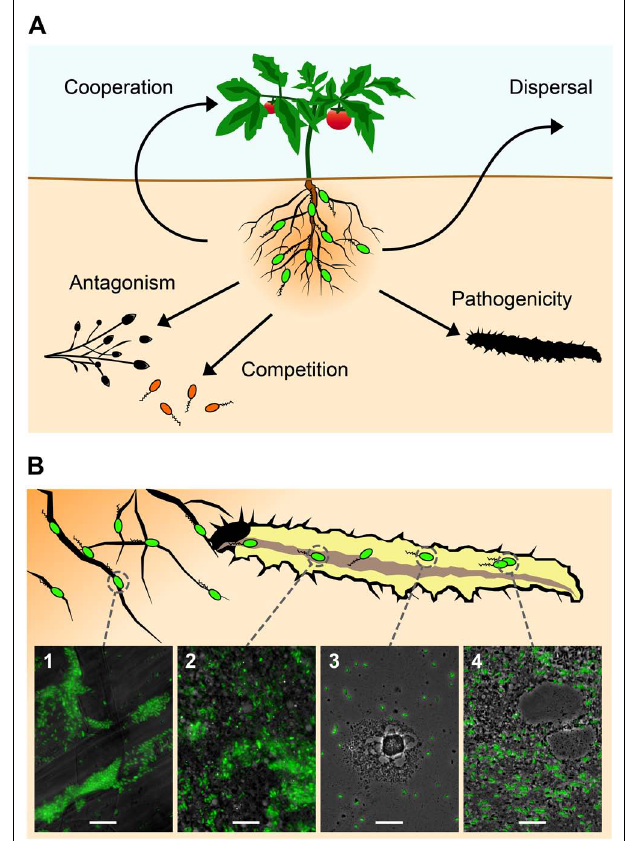
FIGURE 1 | Certain plant root-associated Pseudomonas bacteria exhibit insect pathogenicity as an additional trait to the well-studied biocontrol activity against phytopathogens (see text for more details). (A) The most important interactions of these plant-beneficial pseudomonads (in green) include cooperation with the plant host (growth promotion and induction of systemic resistance) and competition with and antagonism of soil-borne phytopathogens. In addition, they show insecticidal activity and can use insects as vectors for dispersal. (B) Certain strains of Pseudomonas protegens and Pseudomonas chlororaphis are capable of infecting and efficiently killing insect larvae after oral uptake. P. protegens strain CHA0 (here tagged with GFP for microscopical visualization) typically forms microcolonies on roots (1) of various plant species (here tomato). Following ingestion by herbivorous insects, the entomopathogenic P. protegens strain is able to colonize the midgut (2) of pest insect larvae (here the large cabbage white Pieris brassicae ), possibly by competing with the intestinal microbiota. By a so far unknown mechanism CHA0 cells then cross the intestinal epithelial barrier and invade the hemocoel within less than 1 day after oral infection (3). Once